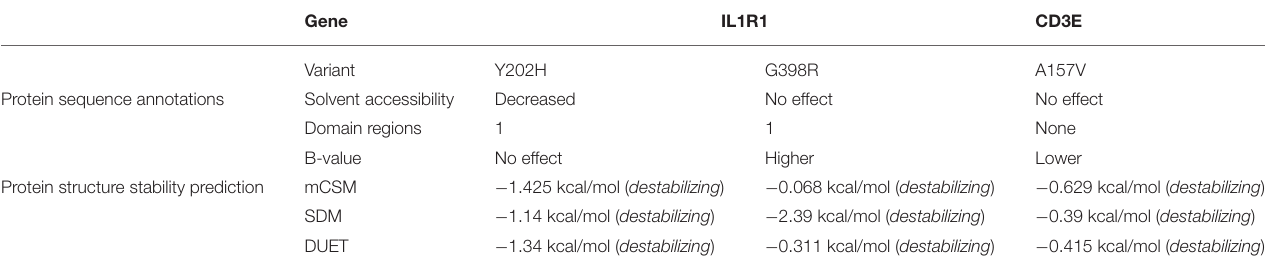
TABLE 4 | Protein sequence annotation and structural stability prediction results for IL1R1 and CD3E